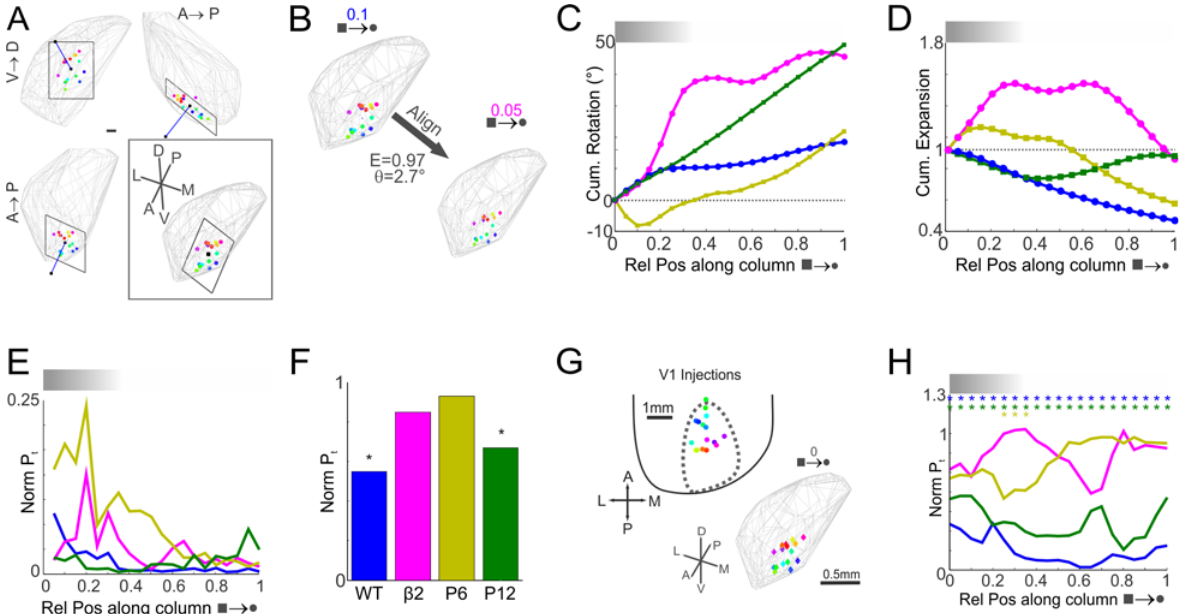
Fig 3. Dynamic Topological and Topographical Order in Geniculo-Cortical Projection Columns. Generating maps of dLGN columns for each 5 th percentile along its length enables estimations of organisation and order. (A) Example of a best-fit plane (normal vector: blue-line) for WT projection columns at 10 th percentile (0.1) position. Inset: collapsed view orthogonal to the plane – end on normal vector. Scale bar is 100 μ m. (B) Example of registration (expansion — E; rotation - θ ) between neighbouring (0.1 and 0.05) WT planes. (C) Cumulative rotation and (D) expansion of each 5 th percentile map aligned to the pial plane (0). (E) Internal topological order within each group compared to the preceding 5 th percentile position. Note, a normalised P t of 1 represents complete disorder while 0 is perfect order. (F) Degree of topological order between the pial and ventral maps of the dLGN. Monte Carlo permutation tests: * (p < 0.05) — statistically significant order. (G) Schematic: correspondence of WT V1 injection sites to dLGN pial plane (0). (H) Degree of topographical order between V1 and the dLGN at each 5 th percentile. Monte Carlo permutation tests: * (p < 0.05) — statistically significant